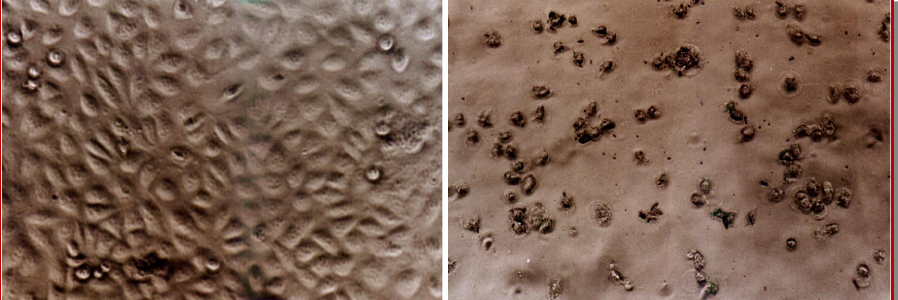
Figure 2: Morphology of cells in different groups under light microscope (~ 100×). (A) Control group; (B) ASODN group (5 × 10 -5